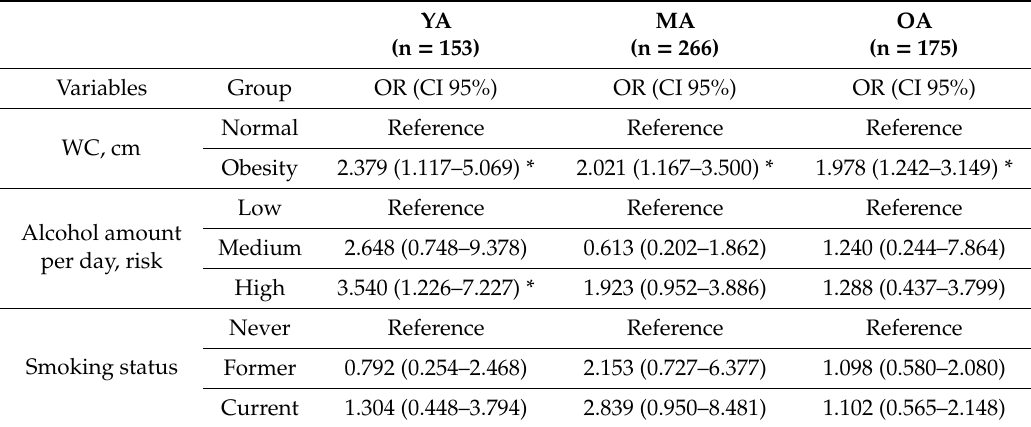
Table 4. Colorectal polyp and health behavior (polyp number 1–2 vs. ≥